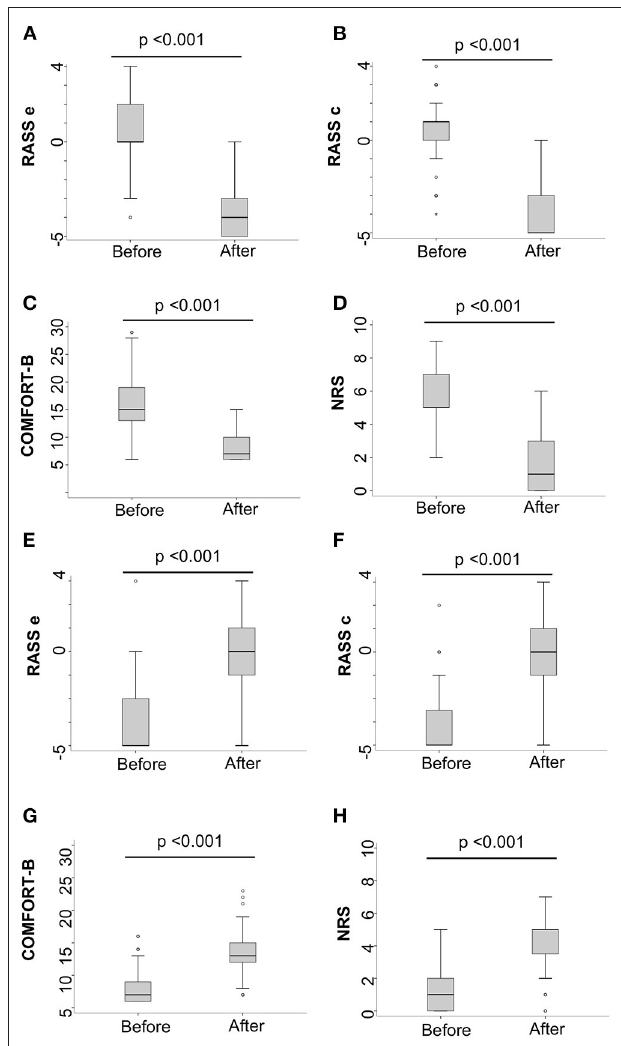
FIGURE 2 | Responsiveness of the RASS: Modification in sedation-agitation scores of the different scales used, before and after a sedative intervention. Increasing/initiation of sedatives (A) RASSe; (B) RASSc; (C) COMFORT-B; (D) NRS. Diminishing/stopping of sedatives (E) RASSe; (F) RASSc; (G) COMFORT-B; (H) NRS. RASSe, Richmond Agitation-Sedation Scale based on the epigraph; RASSc, Richmond Agitation-Sedation Scale based on the description of the conduct; COMFORT-B, COMFORT Behavior Scale; NRS, Numeric Rating Scale.